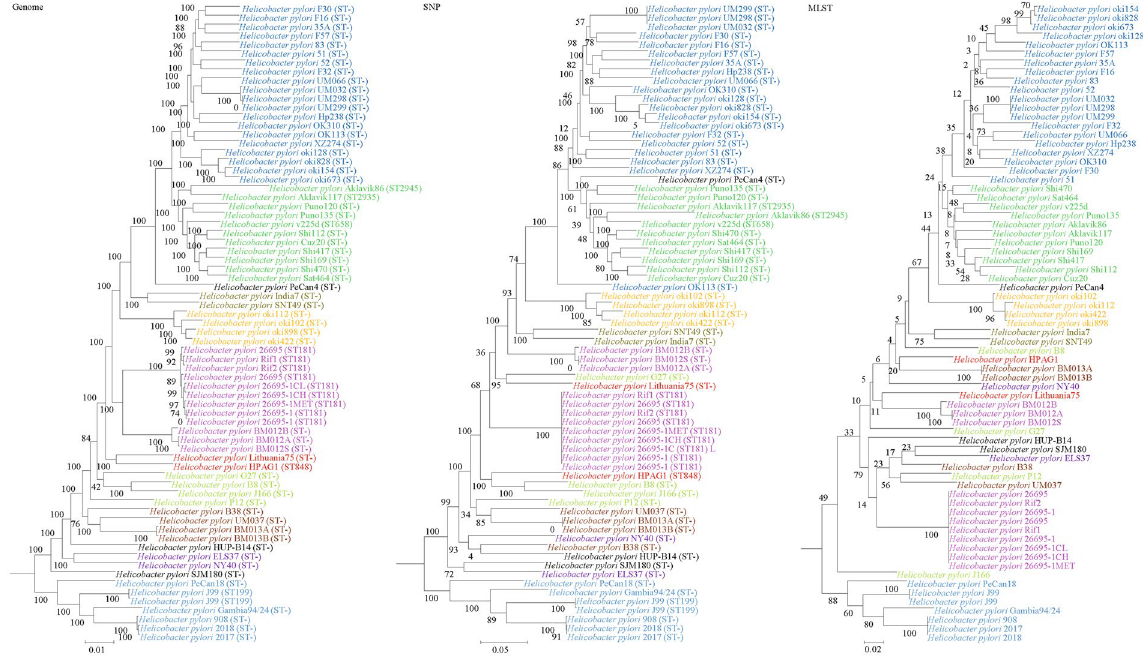
Figure 10. Comparison of phylogenetic trees constructed using genome data (left), SNP data (middle), and MLST data (right) for Helicobacter pylori . Clusters that were manually selected based on the genome trees are illustrated in different colors. A new sequence type is represented by a dash